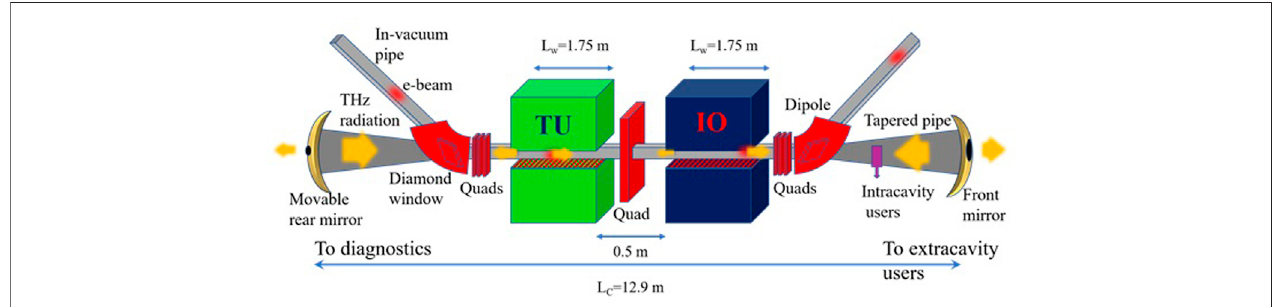
FIGURE1| SchematicoftheTerRA@BriXSinOsource,withdetailsofthesegmentedundulatorsTU&IO. Theradiationproduced bytheelectronsintheundulators isrecirculatedinsideacavityoflengthL c =12.9 m.Theundulatormodulesare1.75 mlongandseparatedby0.5 mwhereaquadrupole,phaseshifters,diagnosticsand correcters are located. The elements are not in scale.